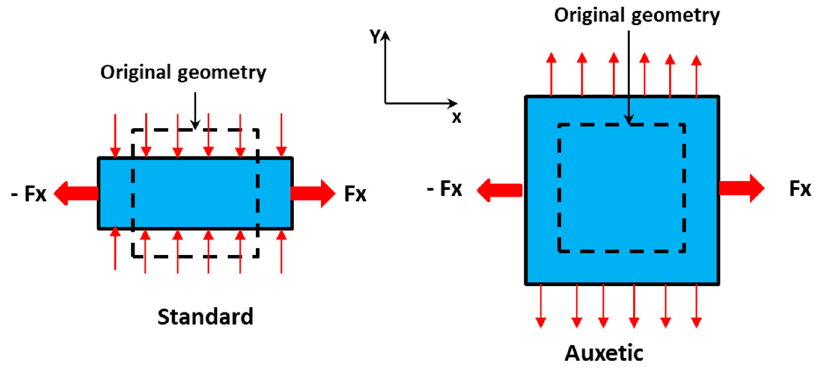
Figure 1. Standard and auxetic structures showing strain relationships and geometries when stretched.